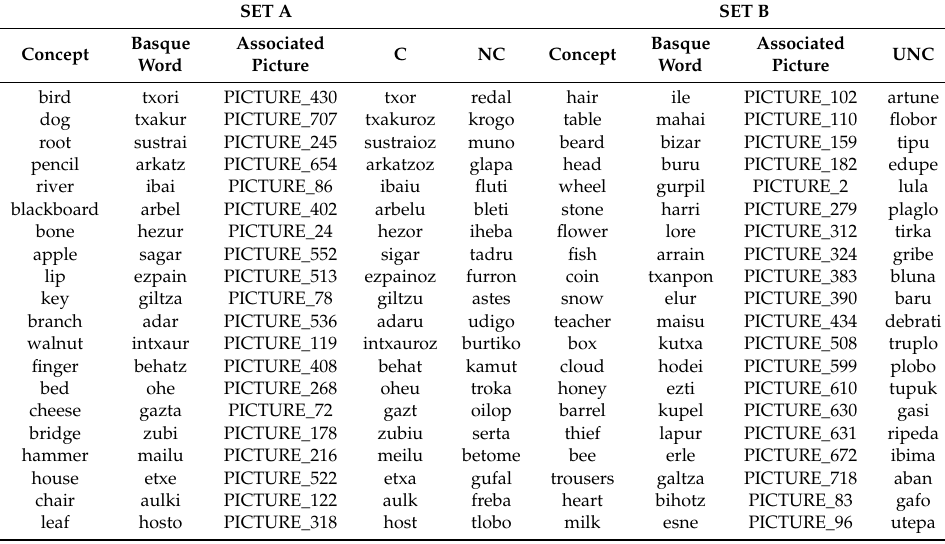
Table A1. Pseudo-words used in the experiment, their Basque and English translations, and the pictures used in the picture-word association